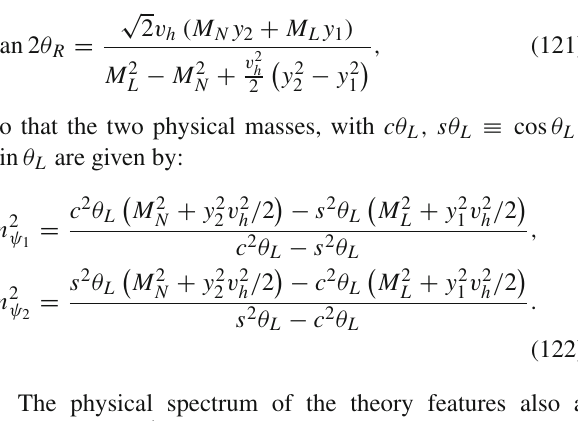
Fig. 25 Combined relic density and DD constraints for the Singlet- Doublet Dirac fermion DM model in the bi-dimensional plane ( M , M ) by fixing y = y = 0 . 1. The correct DM relic density L N 1 2 is achieved, through thermal freeze-out, along the red contour. The blue region is excluded by limits on SI interactions from the XENON1T experiment while the magenta and purple regions will be excluded in the case of absence of signals at XENON1T, assuming 2 years of expo- sure time, and LZ,